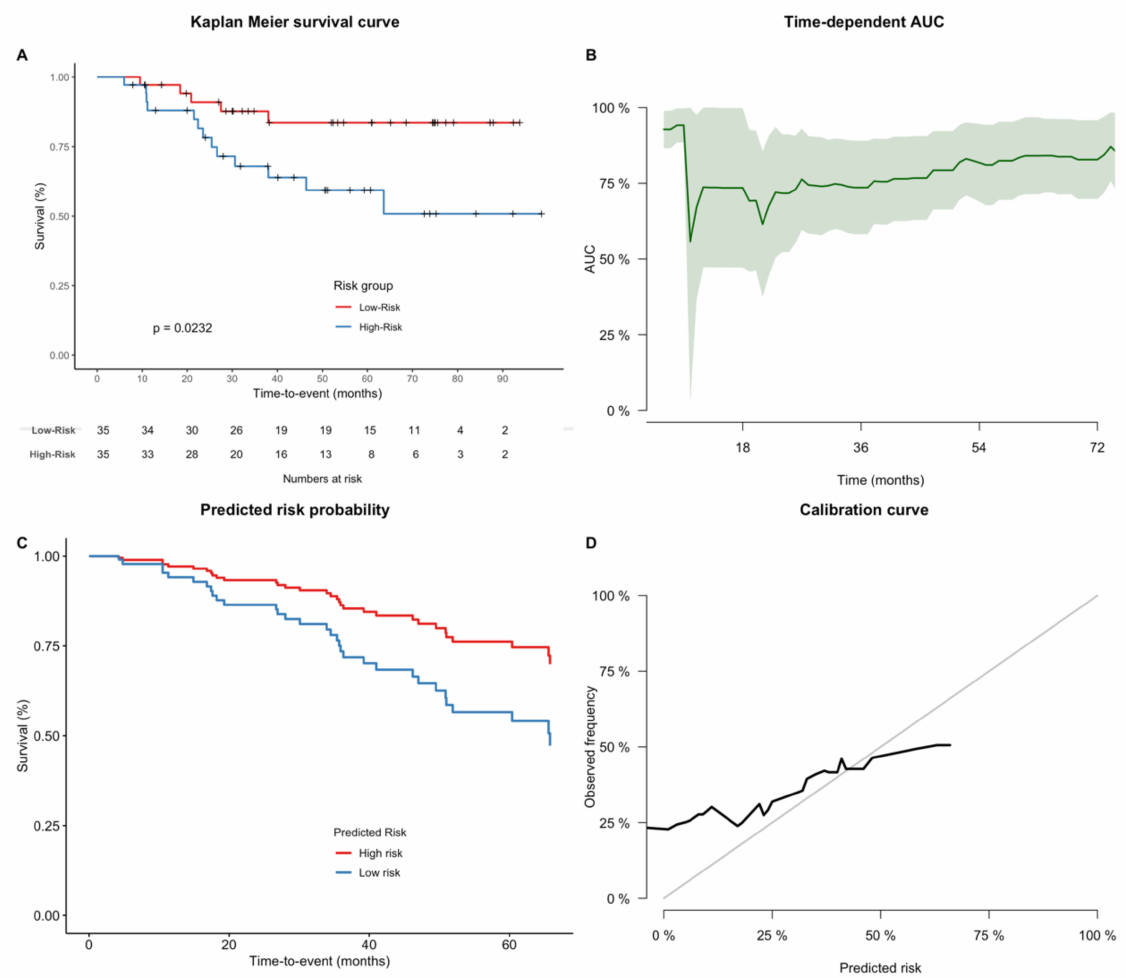
Figure 5. Prognostic performance of the Radiomics-T2+AJCC+Age model in the testing cohort. ( A ) Kaplan–Meier survival curve. Cohorts were split based on the median predictor value determined on the training cohort. ( B ) Time-dependent area under the receiver operating curve (AUC). ( C ) Predicted survival probabilities of the Cox proportional hazards model. ( D ) Calibration curve of the Cox proportional hazards